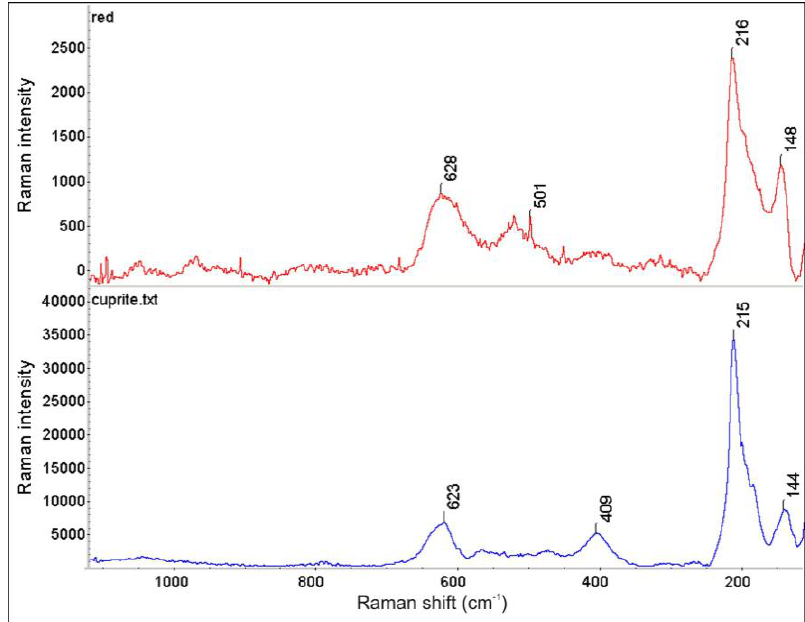
Figure 9. Comparison of the Raman spectrum of cuprite Cu Raman spectrum of the red corrosion layer shown in Figure 5 (upper